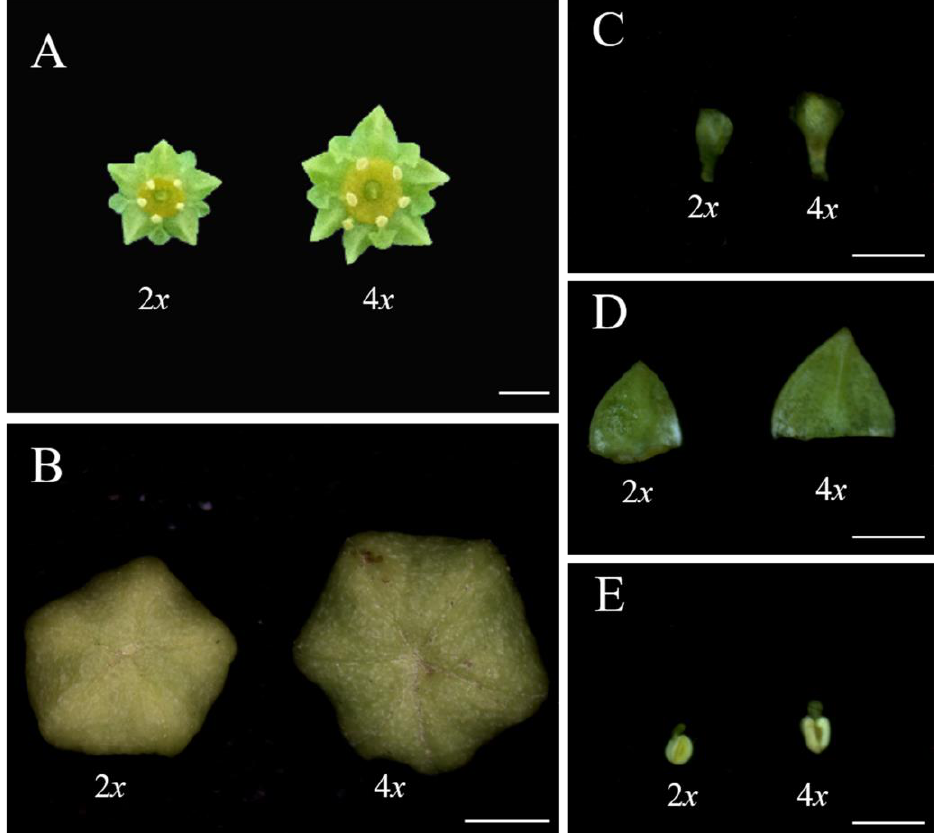
Figure 3. Flower morphologies of ‘Xingtai0604′ (2 x ) and ‘Zhuguang’ (4 x ), ( A ) flowers, bar represents